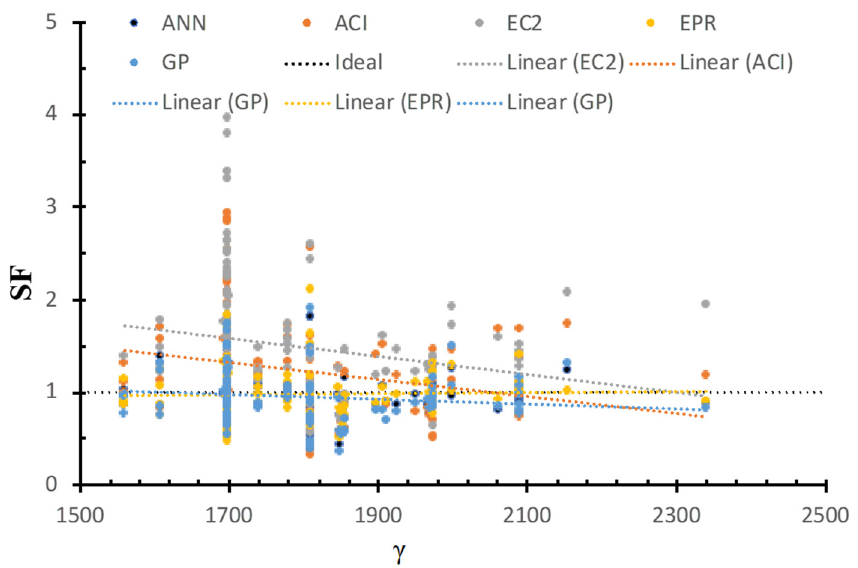
Figure 10. SF calculated using various models versus γ .